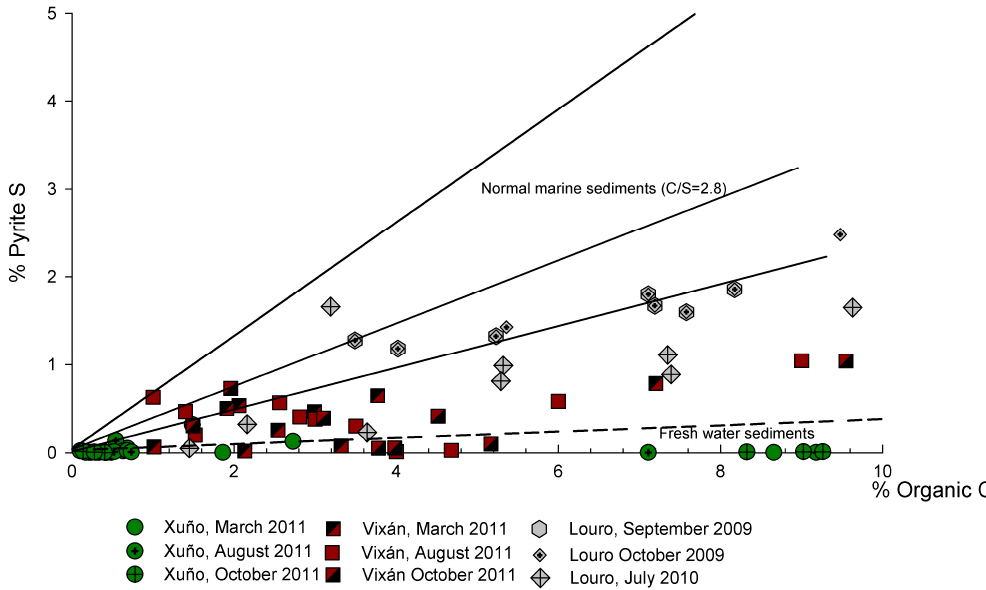
Figure 5. Pyritic S to organic C ratio in sediments. Solid lines represent the typical organic C/pyritic S ratio for normal modern marine sediments (C/S ratio = 2.8 ± 0.8, data from [18,23]), and the dashed line represents the C/S ratio for freshwater sediments, data from [17].